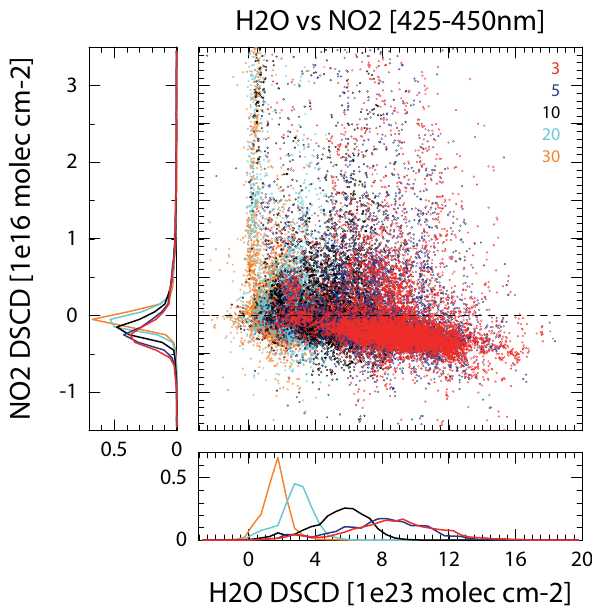
Fig. 7. Scatter plot of H 2 O DSCD versus NO 2 DSCD for a fitting window of 425–450nm at elevation angles of 3 ◦ , 5 ◦ , 10 ◦ , 20 ◦ and 30 ◦ .